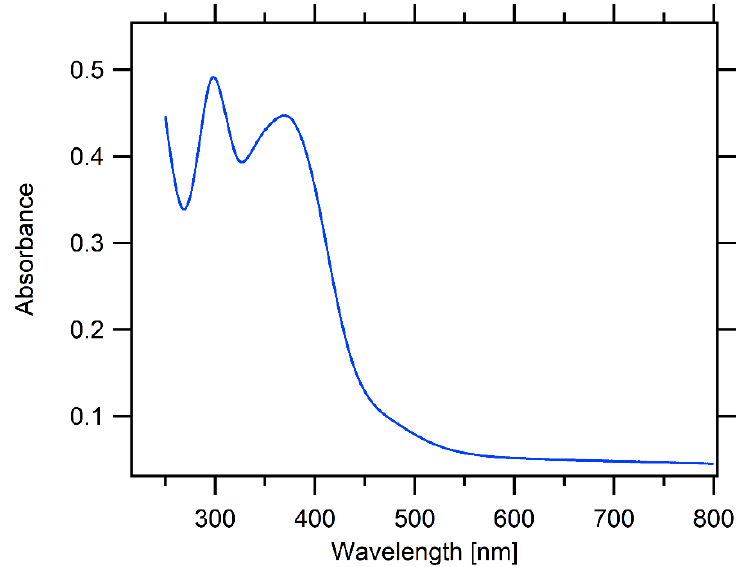
Figure 4. The optical (UV-Vis) spectrum of bTAThDaz thin film on quartz substrate.